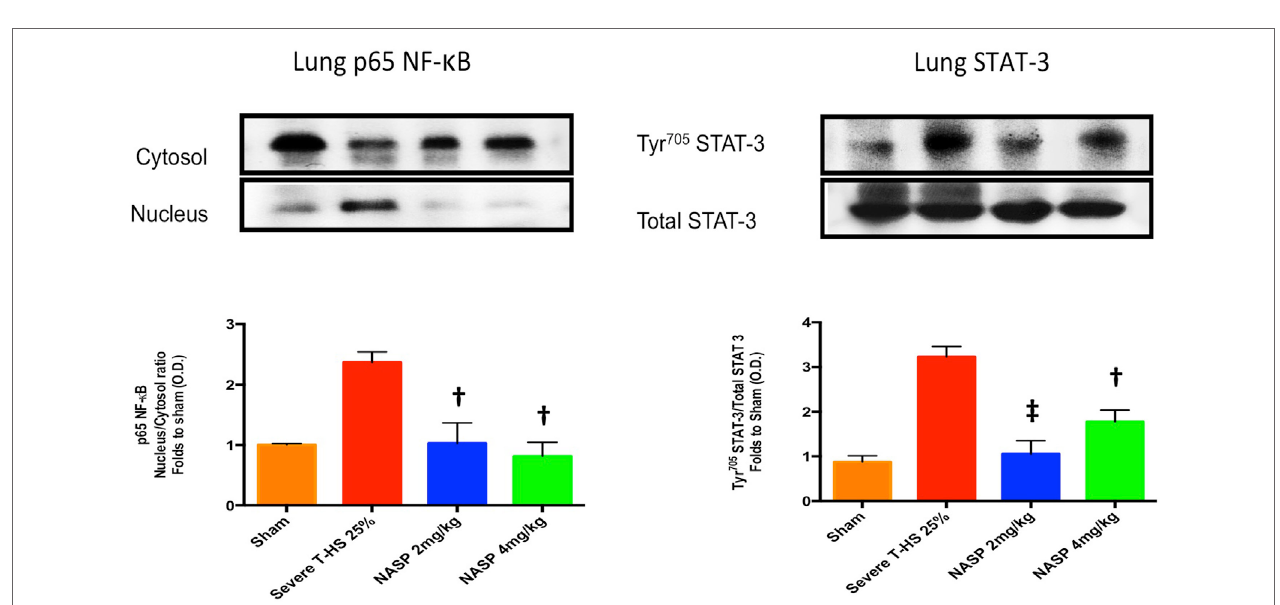
FigUre 6 | Western blot analysis of lung homogenates. Phosphorylated NF- κ B levels were markedly increased at 6 h post T-HS with attenuation to sham levels with nucleic acid scavenging polymer (NASP) (hexadimethrine bromide) 2 and 4 mg/kg dosing, † denotes p < 0.01 vs untreated T-HS 25%. Phosphorylated STAT-3 levels were similarly attenuated by NASP 2 mg/kg, ‡ denotes p < 0.001 vs untreated T-HS 25%, less so with NASP 4 mg/kg, † denotes p < 0.01 vs untreated T-HS 25%. n = 3–4 animals per group. ANOVA/Tukey’s. Bar graphs indicate mean values with SEM. NASP 1 mg/kg data not